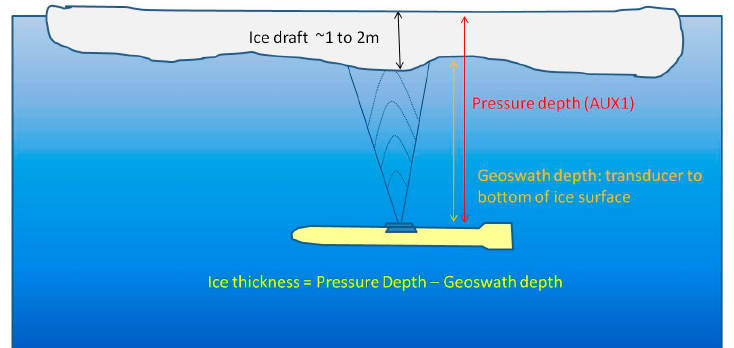
Figure 7. Concept diagram of the ice thickness calculation based on AUV depth.